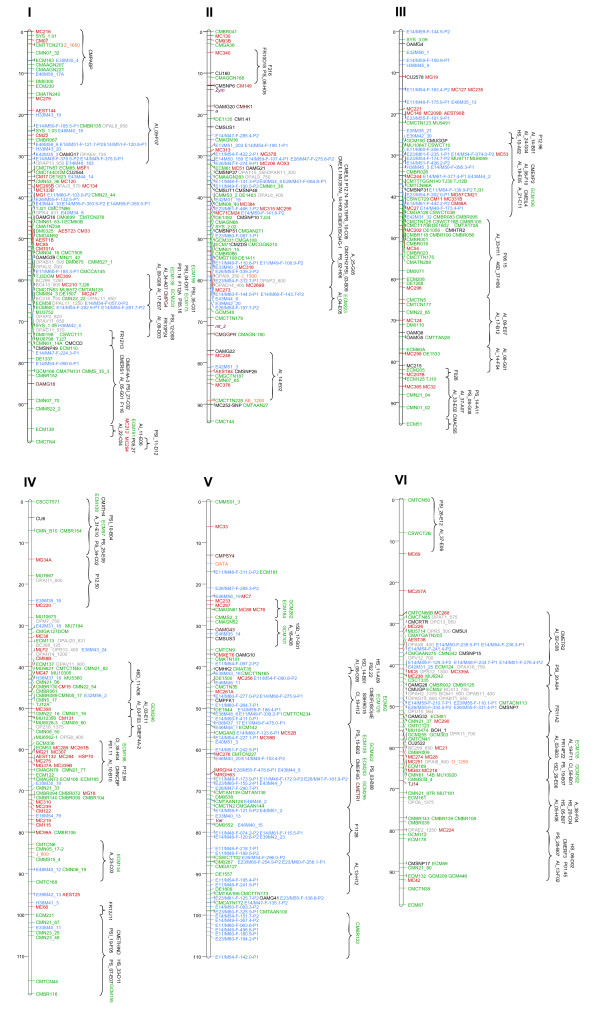
Integrated melon marker map. Linkage groups I to VI. Six out of the 12 melon linkage groups (LG) are designated with Roman numerals (I-VI) according to Perin et al. (2002) [11]. Marker type is indicated by colours: SSRs (green), SNPs (black), AFLPs (blue), RFLPs (red), RAPD (grey), IMA (orange), morphological traits (purple) and indel (brown). The map distance is given in centiMorgans (cM) from the top of each LG on the left.